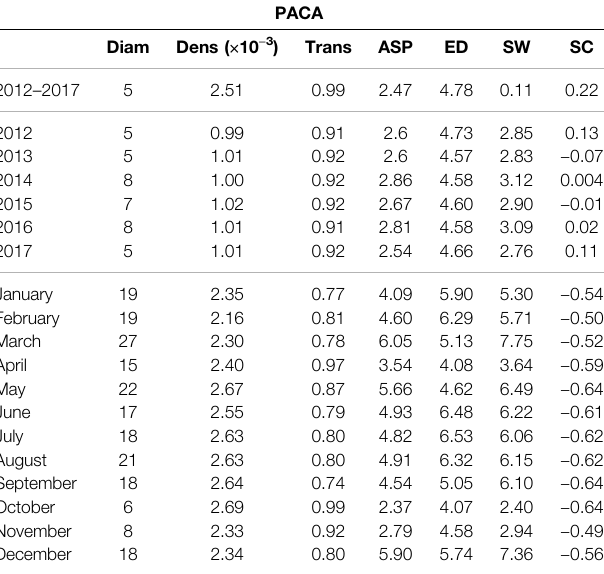
TABLE 2 | Network indices [diameter (Diam), density (Dens), transitivity (Trans), average shortest path (ASP), effective distance (ED), small worldness (SW), strength correlation (SC)] calculated from the networks covering PACA and estimated in three temporal contexts: the entire period 2012 – 2017, yearly time periods from 2012 to 2017 and monthly time